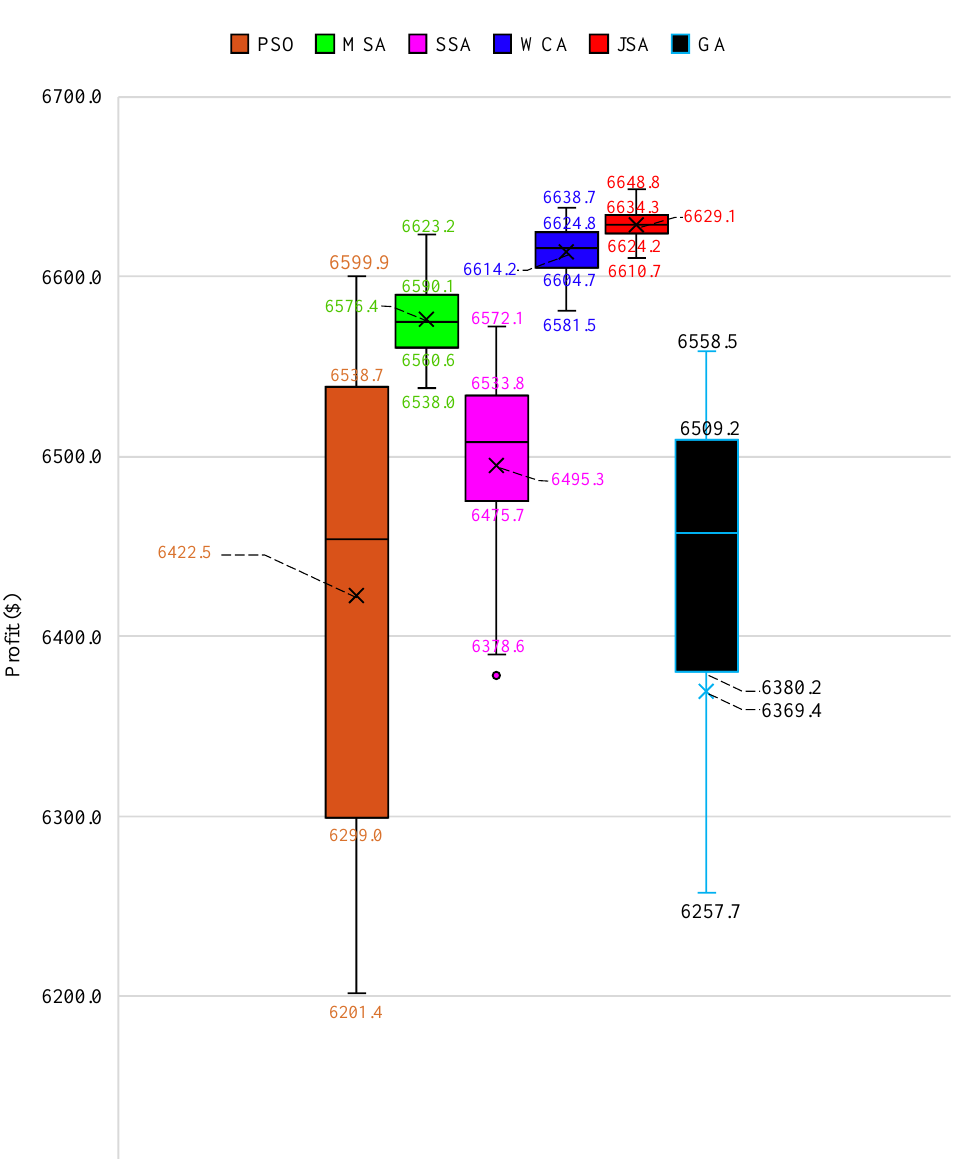
Figure 4. Summary of results obtained for Case 1.